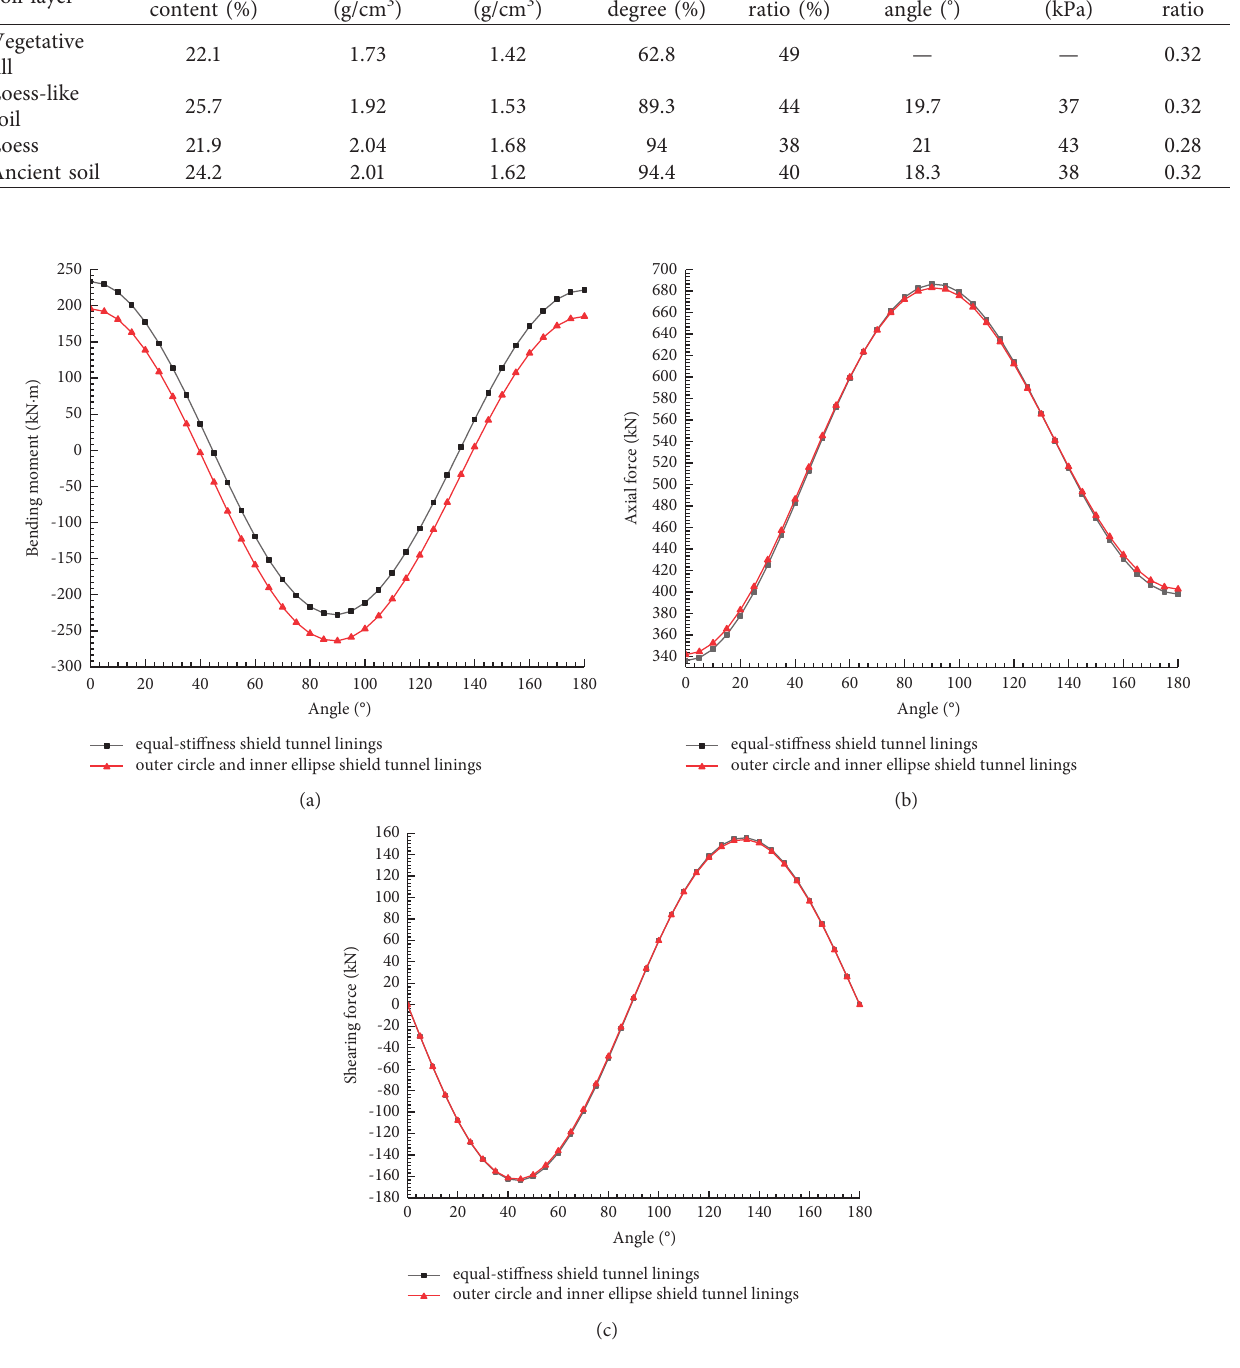
Figure 5: Comparison of internal force distribution between iso-stiffness shield tunnel linings and outer circle and inner ellipse shield tunnel linings. (a) Bending moment. (b) Axial force. (c) Shear